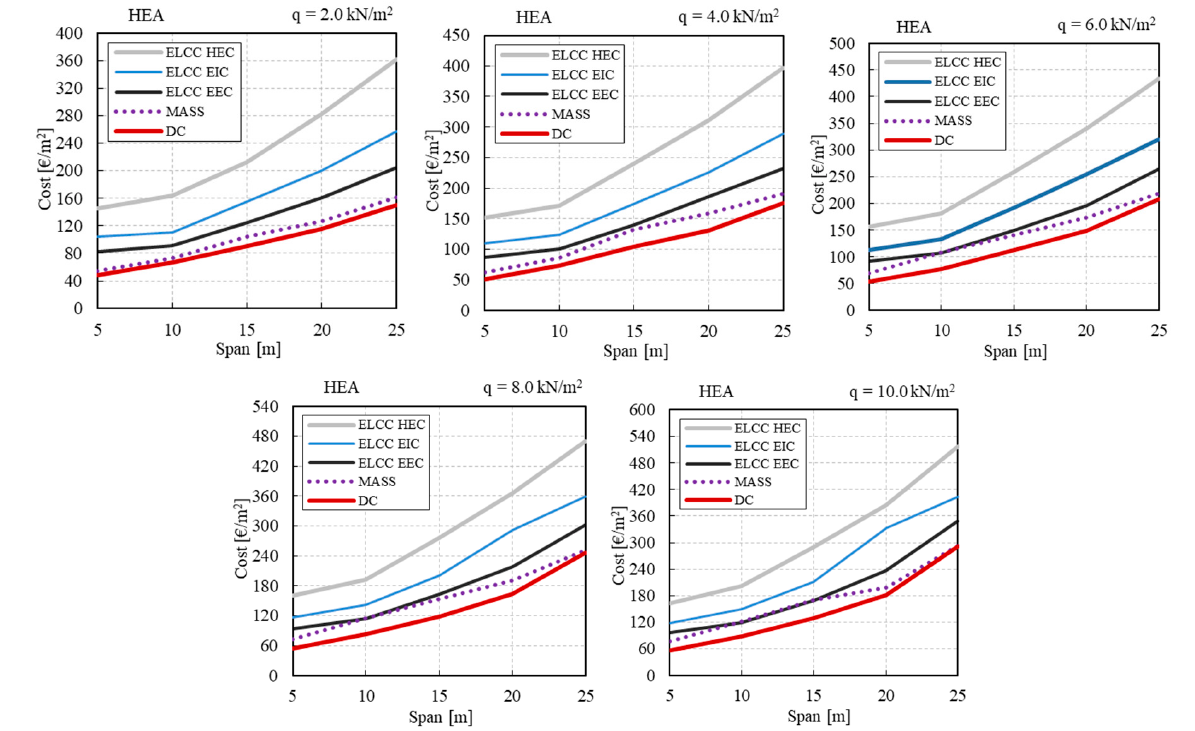
Figure 12. Diagrams of the calculated costs of the CFSHEA structures for different objective functions.